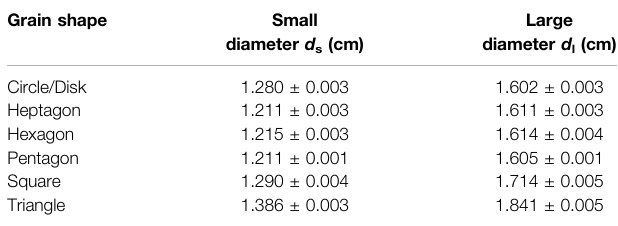
TABLE 1 | Sizes of photoelastic grains of varying